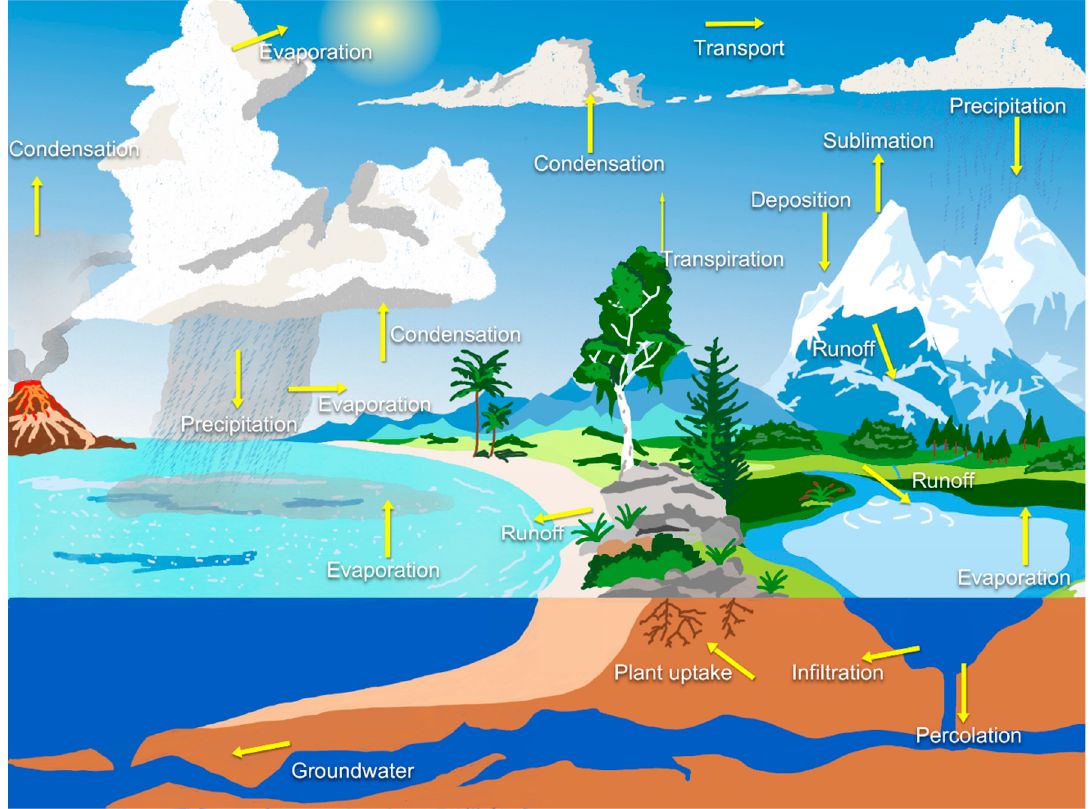
Figure 1. The terrestrial water cycle (or hydrological cycle) and its components.